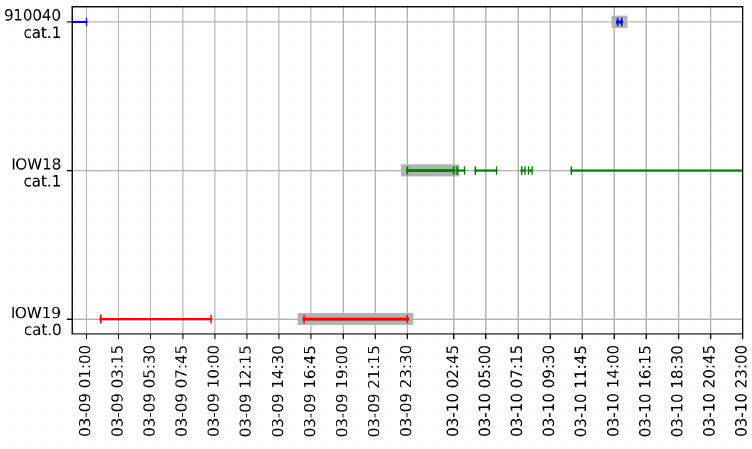
Figure 19. Flow Path query result for Query